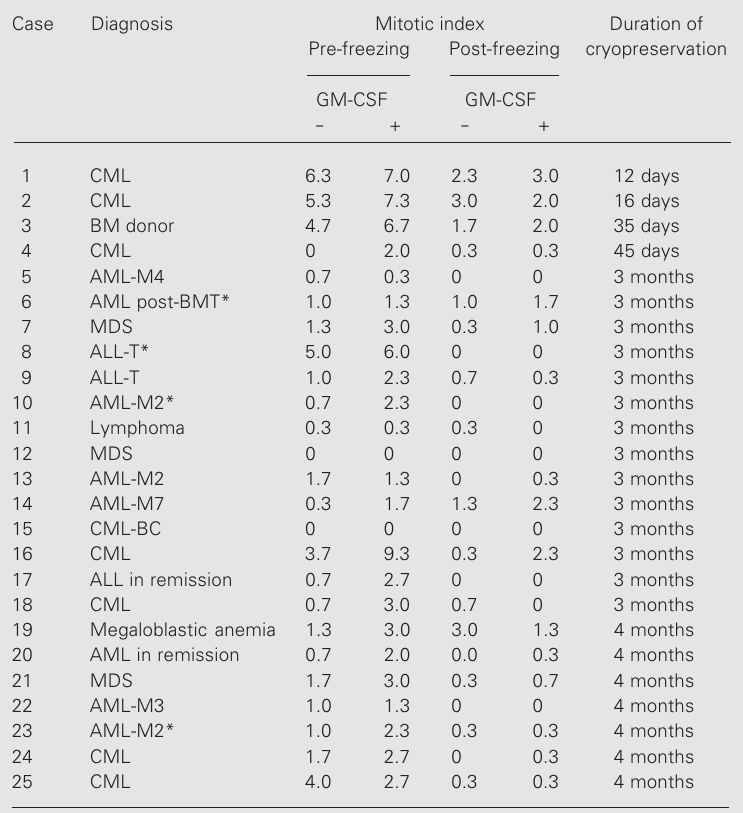
Table 1. Patient diagnosis and mitotic index data obtained for each pre- and post- freezing culture and cryopreservation period.